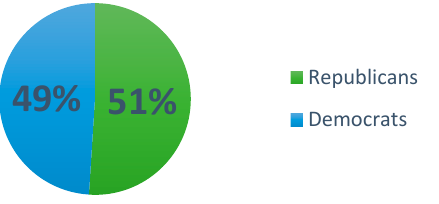
Figure 2. Input data divided into two columns (content, party) in the DataFrame object. In order not to affect the performance of the model and to have a balanced data set, the Democratic and Republican tweets were divided in almost equal sets. Thus, as a percentage, we have 49% Democratic tweets and 51% Republican tweets (Figure 3). Numerically, there are 44,095 posts labeled as Republican and 42,365 Democratic posts.